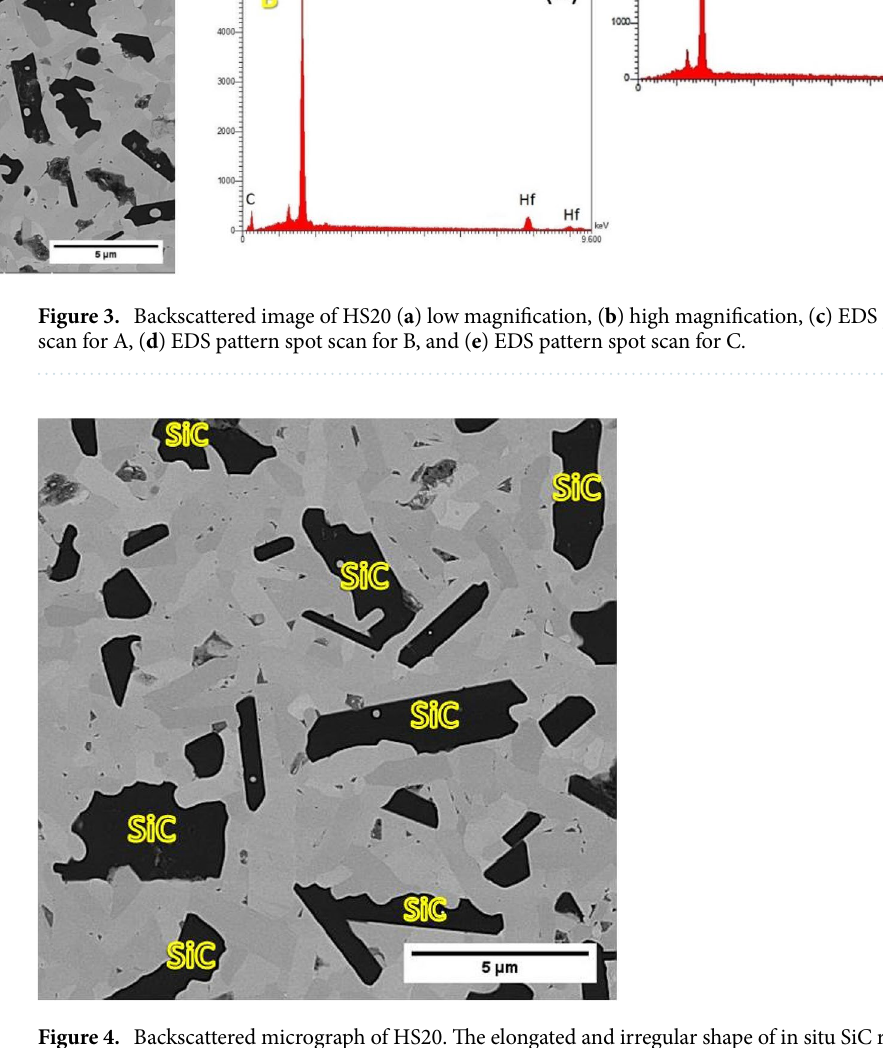
Figure 4. Backscattered micrograph of HS20. The elongated and irregular shape of in situ SiC reinforcement is